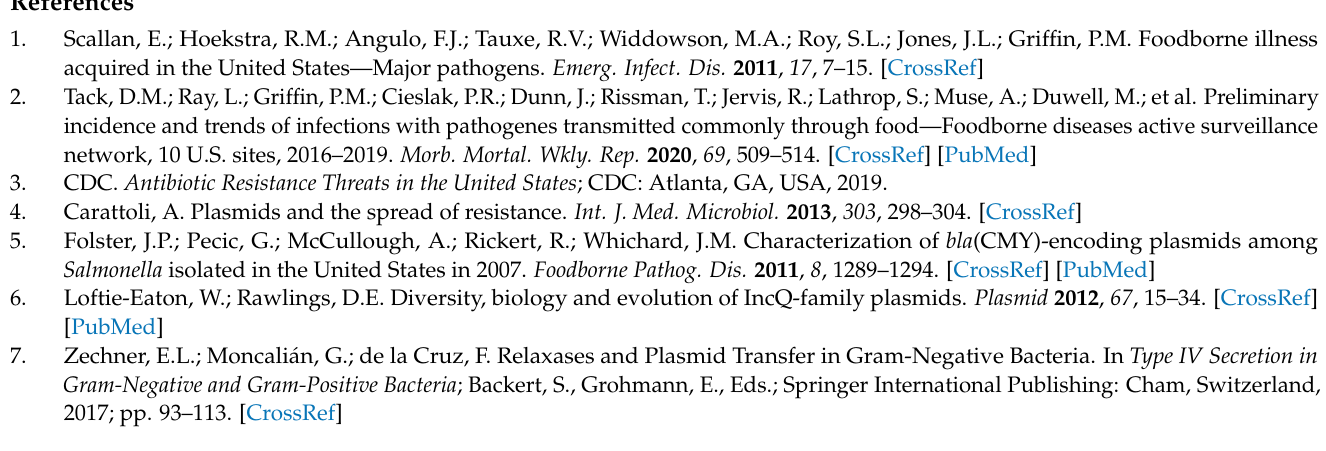
investigated, Figure S3: progressiveMauve alignment of the transfer regions of R6K, p2X1, p3X1-TC, and p12X4-TC, Figure S4: progressiveMauve alignment of the transfer regions of R64, p2I1, p5I1-TC, and